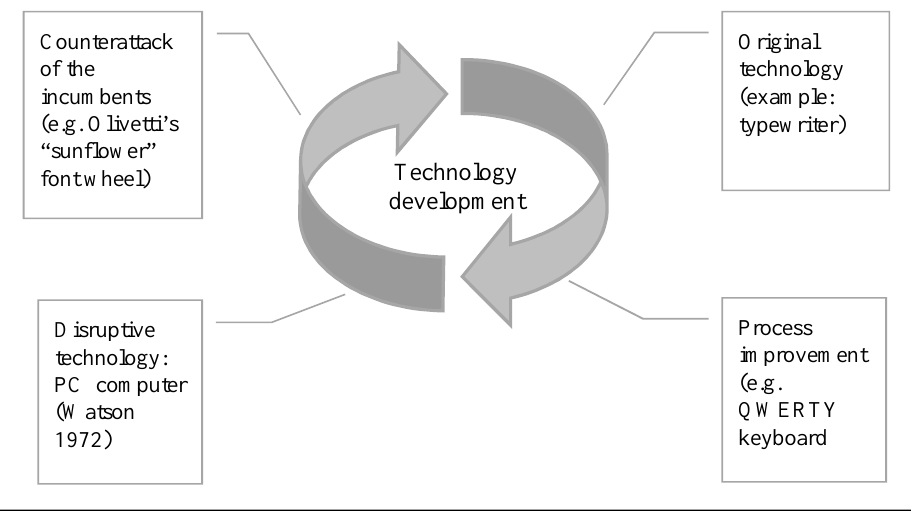
Figure 2 – Sustaining technology (product and process innovation),